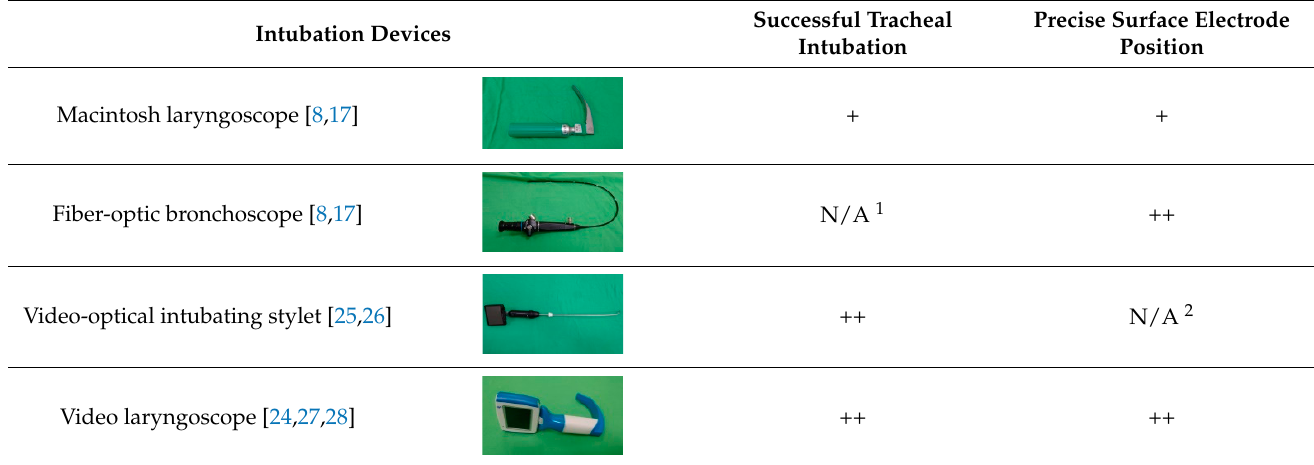
Table 1. Rating for intubation devices to place an endotracheal tube and confirm electrode positioning. Intubation Devices